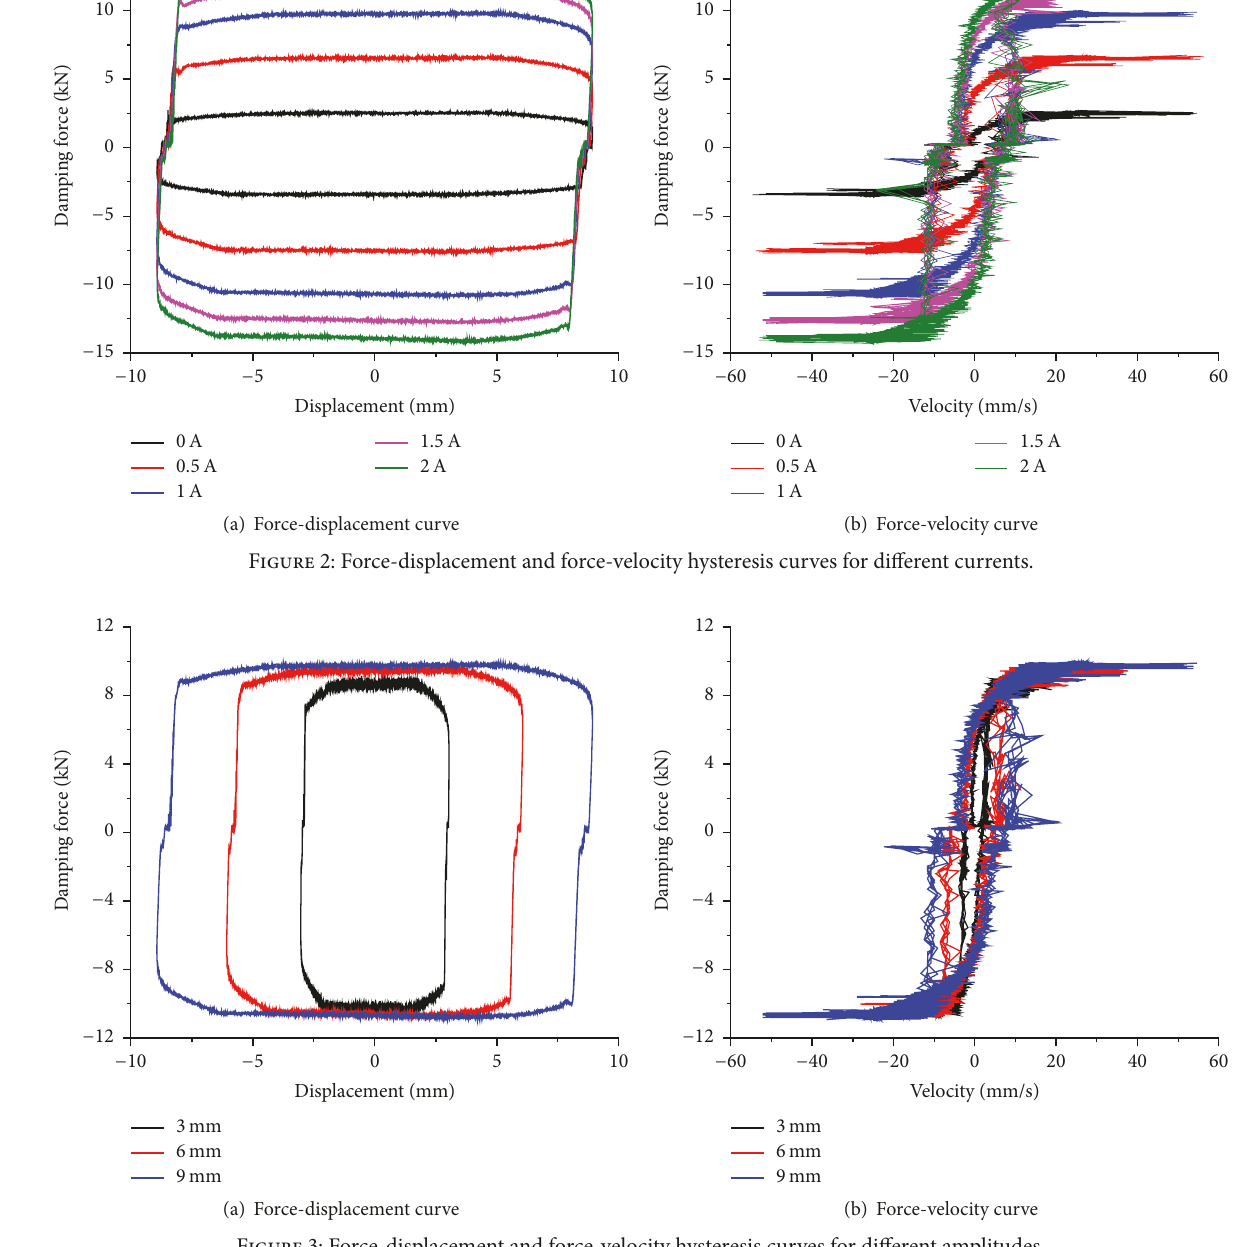
Figure 3: Force-displacement and force-velocity hysteresis curves for different